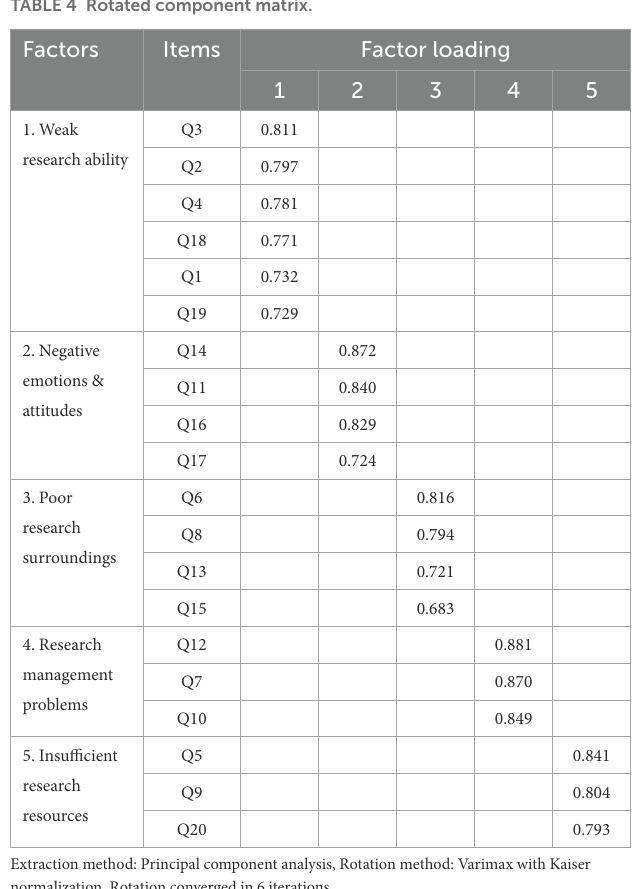
TABLE 4 Rotated component